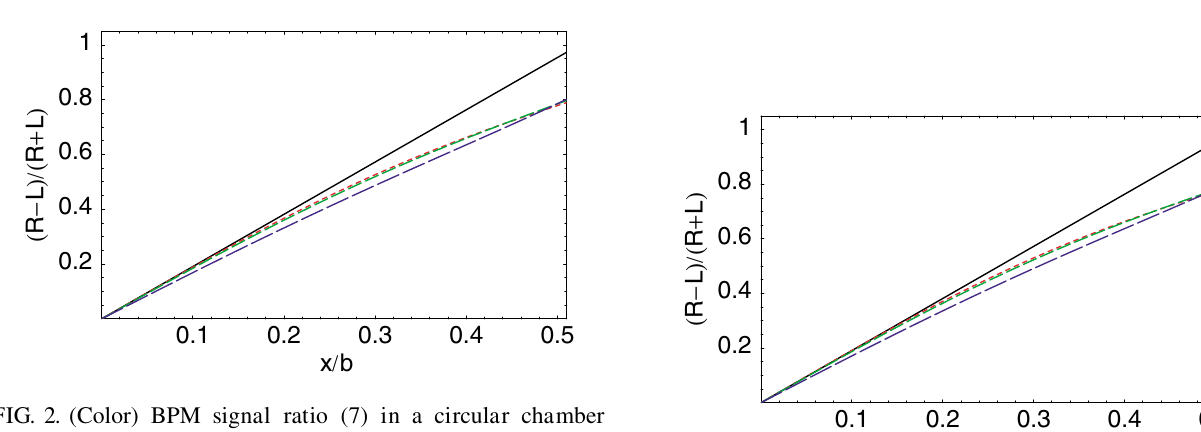
FIG. 2. (Color) BPM signal ratio (7) in a circular chamber versus beam center position x=b for three vertical beam offsets y=b (cid:3) 0 ; 1 = 4 ; 1 = 2 (short-dashed, dashed, long-dashed lines) without beam-size corrections (pencil beam, (cid:7) Solid line shows the linear part of the BPM response.